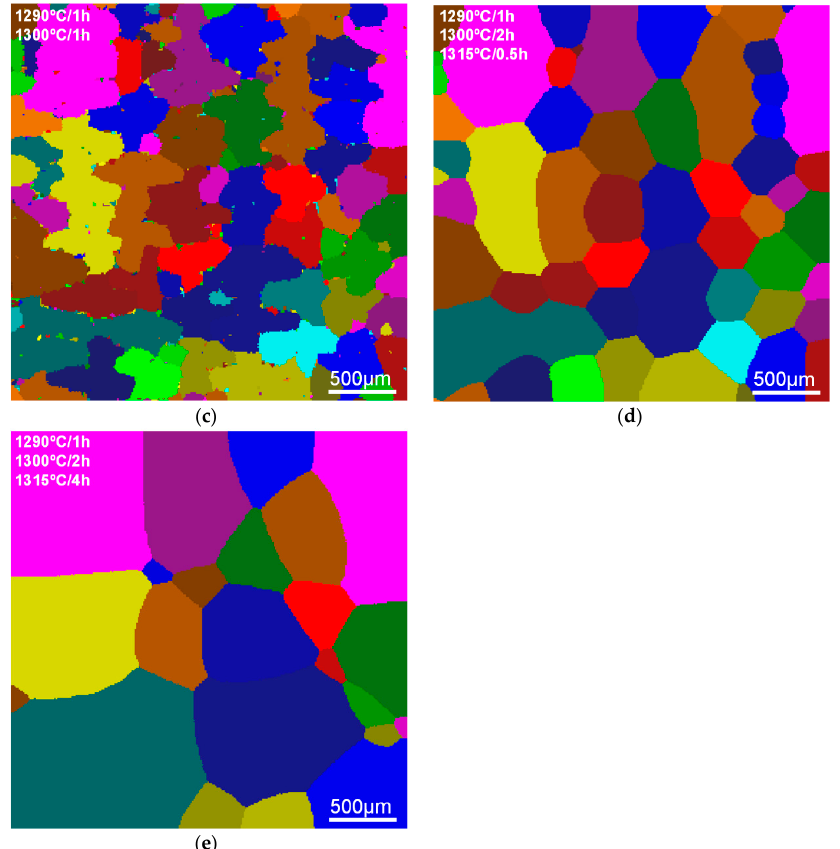
Figure 7. Simulated RX morphologies of S-980 during SSHT. ( a ) S-980-1; ( b ) S-980-2; ( c ) S-980-3; ( d ) S- 980-4; ( e ) S-980-5.